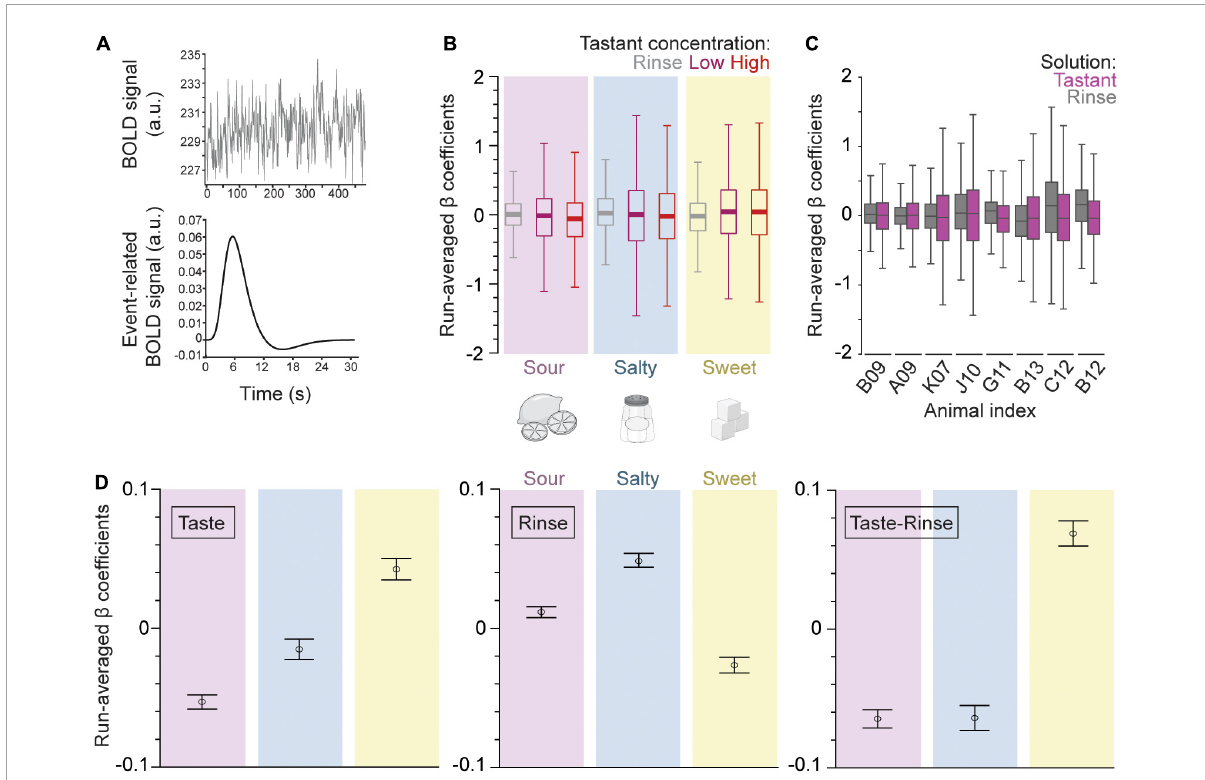
FIGURE2 Gustatory connectome regions as a whole respond differentially to different taste qualities but not to taste concentrations. (A) The fMRI BOLD voxel signal time course was input into the beta-series general linear model (GLM). This time course is averaged across all voxels within a defined region space (upper panel, example from dAIC, or dorsal anterior insular cortex). The beta-series model outputs a convolved event-fitted BOLD response with amplitude equal to the beta weight for each trial presentation (lower panel). (B) Boxplot of the trial average β coefficients from the GLM model for low (magenta) and high (red) concentration tastant as well as rinse (gray) across sour (pink, n = 6,032), salty (blue, n = 5,220), and sweet (yellow, n = 4,756) taste runs, and across all regions taken together. Note the higher variance in the distribution of tastant as compared to rinse β coefficients across runs. The consistency of this effect is seen in the panel (C) boxplot of the trial average for rinse (gray) and tastant (magenta, low and high concentrations combined) β coefficients across individual macaque monkeys ( n = 8 subjects; n = 290–3132 β coefficients per subject). Outliers were removed from the boxplots for visualization purposes in panels (B,C) . (D) Error bar plot of taste quality specific trial average β coefficients (mean ± SEM, n = 6032, 5212, 4756 for sour, salty, and sweet trials, respectively) for the taste (left panel) and rinse trial blocks (middle) as well as their difference (right). Note that sweet generates the largest response in the brain regions of the gustatory connectome ( p = 5.1 × 10 - 37 , one-way ANOVA of taste and rinse